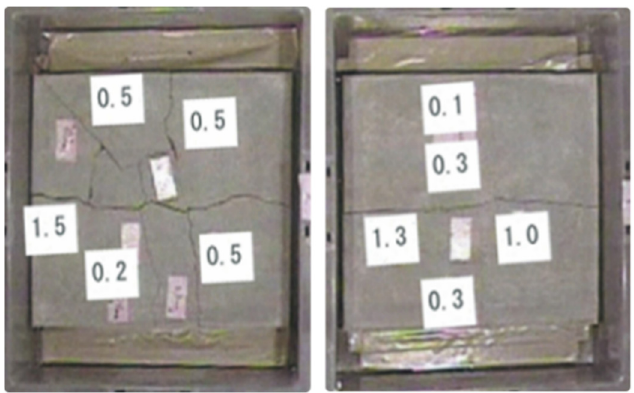
Figure 4. The test piece and corresponding crack width (the number in the figure is the width of the crack there in